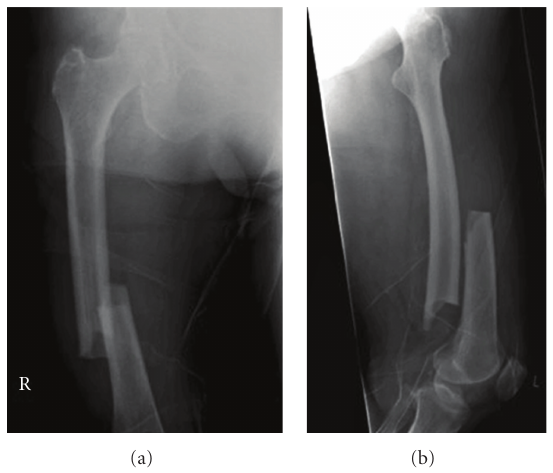
Figure 1: A case of bilateral femur fractures in a patient who had been on alendronate therapy for six